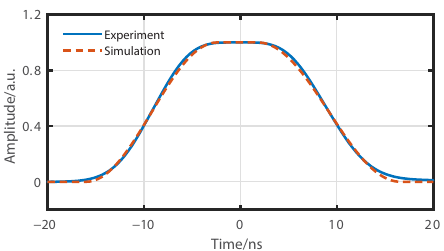
Figure 5. The measured degradation function of a 20-ns pulse for our experimental ROTDR setup (blue curve) and the numerically generated degradation function of 18 ns for simulations (red